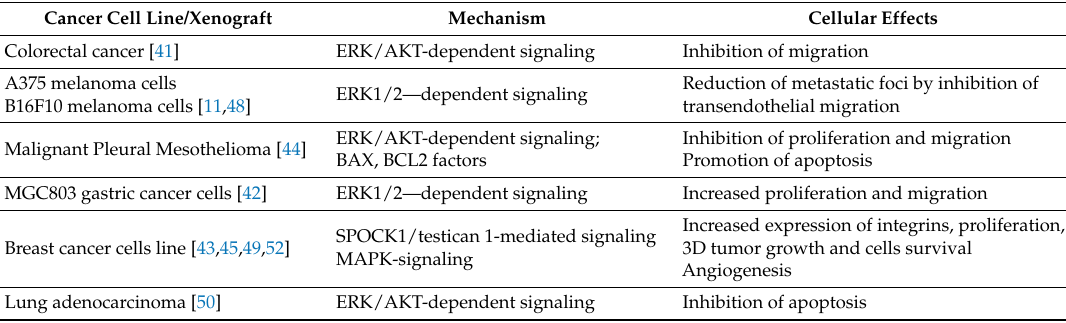
Table 2. Distinct cellular effects mediated by endothelial protein C receptor (EPCR) in different cancer